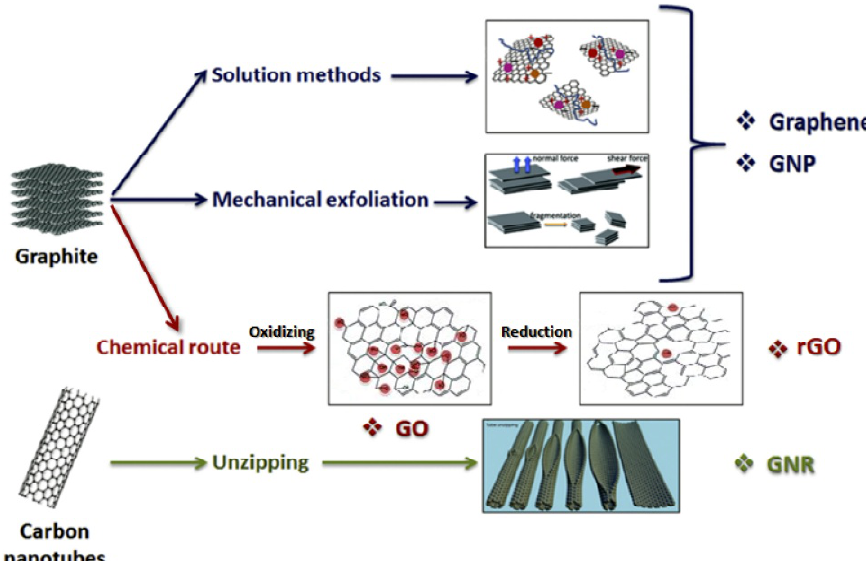
Fig. 1. The common scheme of graphene additives synthesis, summary of the approaches reported in